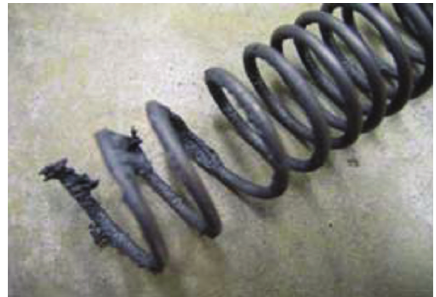
Figure 3: Photographs of experimental Shchelkin spiral